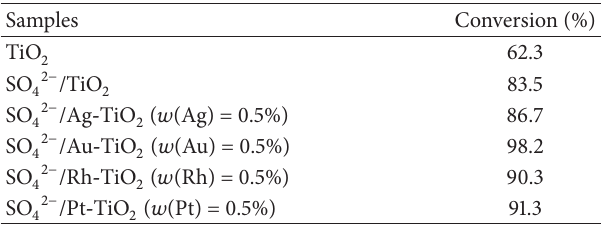
Table 3: CABu conversion of esterification reaction catalyzed